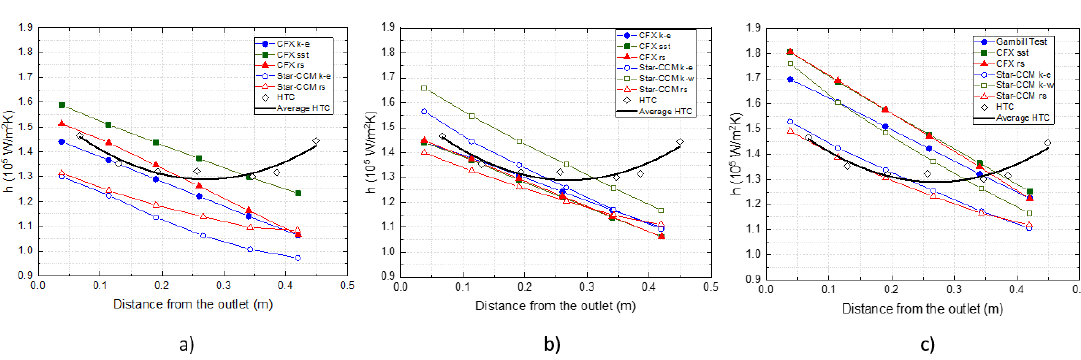
Figure 9: The heat transfer coefficients for all simulations: mesh 2a and 2b with smooth walls (a), mesh 1a and 1b with smooth walls (b) and mesh 1a and 1b with rough walls